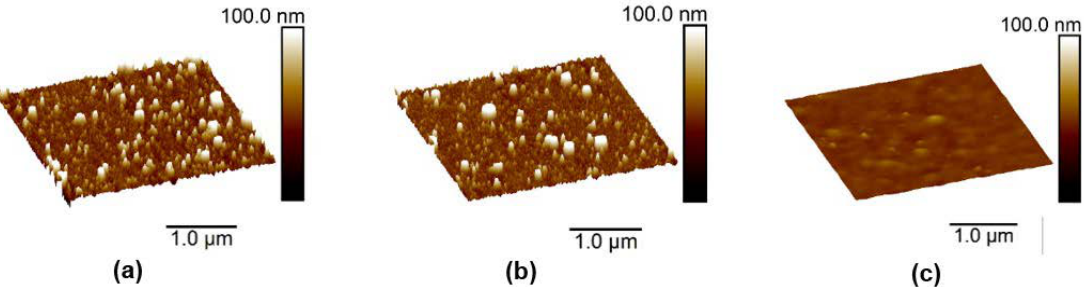
Figure 5. Atomic force microscopy 3D height images of ( a ) (BPEI/ARS) 20 , ( b ) (ARS/(PSS+ARS)) 20 and ( c ) ((BPEI+ARS)/PSS) 20 films. ( c ) ((BPEI+ARS)/PSS) 20